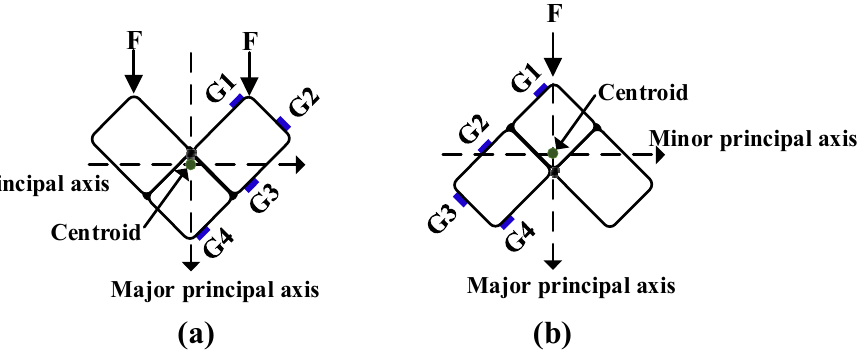
Figure 12. Position of longitudinal strain gauges: ( a ) Load at the toes; ( b ) Load at the